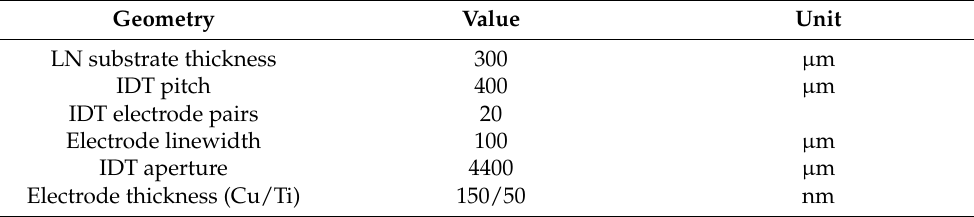
Figure 3. ( a ) Frequency dispersion relations of the Lamb-wave eigenmodes. ( b ) Measured S21 spectrum of the fabricated device (black curve) and simulated displacement spectrum excited simultaneously by the double IDTs (blue curve). ( c ) Vertical surface displacement component u y of the standing A0 and S0 modes at different acoustic phases ( ω t = 0, π /3, and 2 π /3) and their cross-sectional displacement profiles excited at their corresponding peak frequencies. Table 2. Design information of the substrate and IDTs.